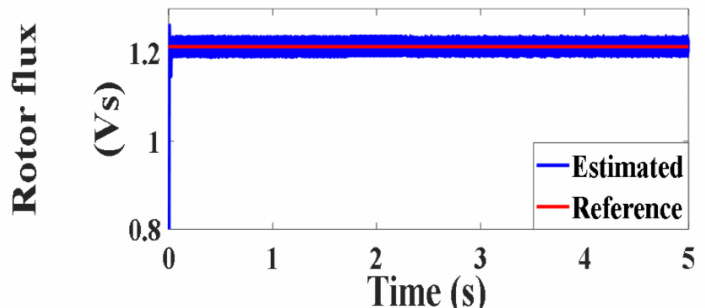
Figure 41. Rotor flux under MPDTC (Vs).